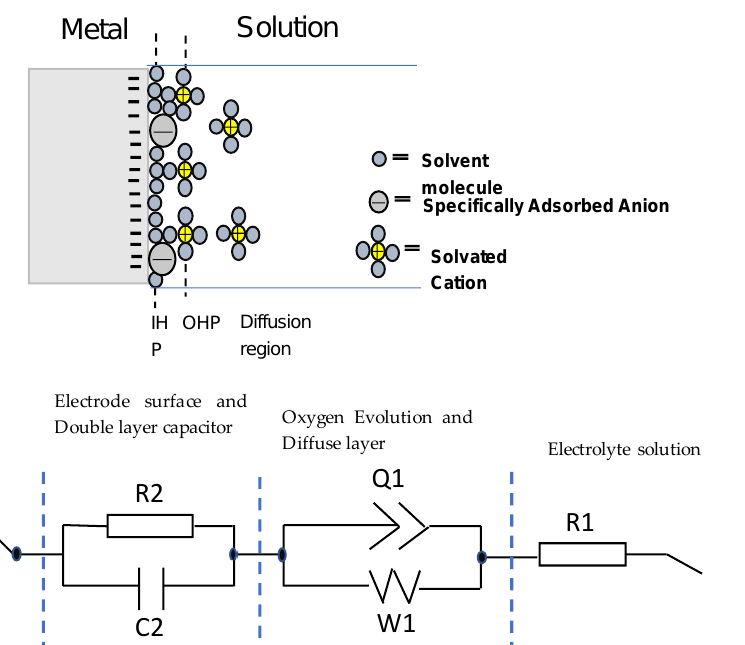
Figure 3. Schematic representation of a metal electrode surface in the solution and the equivalent electrical circuit used to fit the impedance data. R1 and R2 are the electrolyte and charge transfer resistance, respectively. Q1 is the constant phase element, W1 is a Warburg element, and C2 is a capacitor. Table 2. Parameters from the fitting of the Nyquist plot to an equivalent electrical circuit.